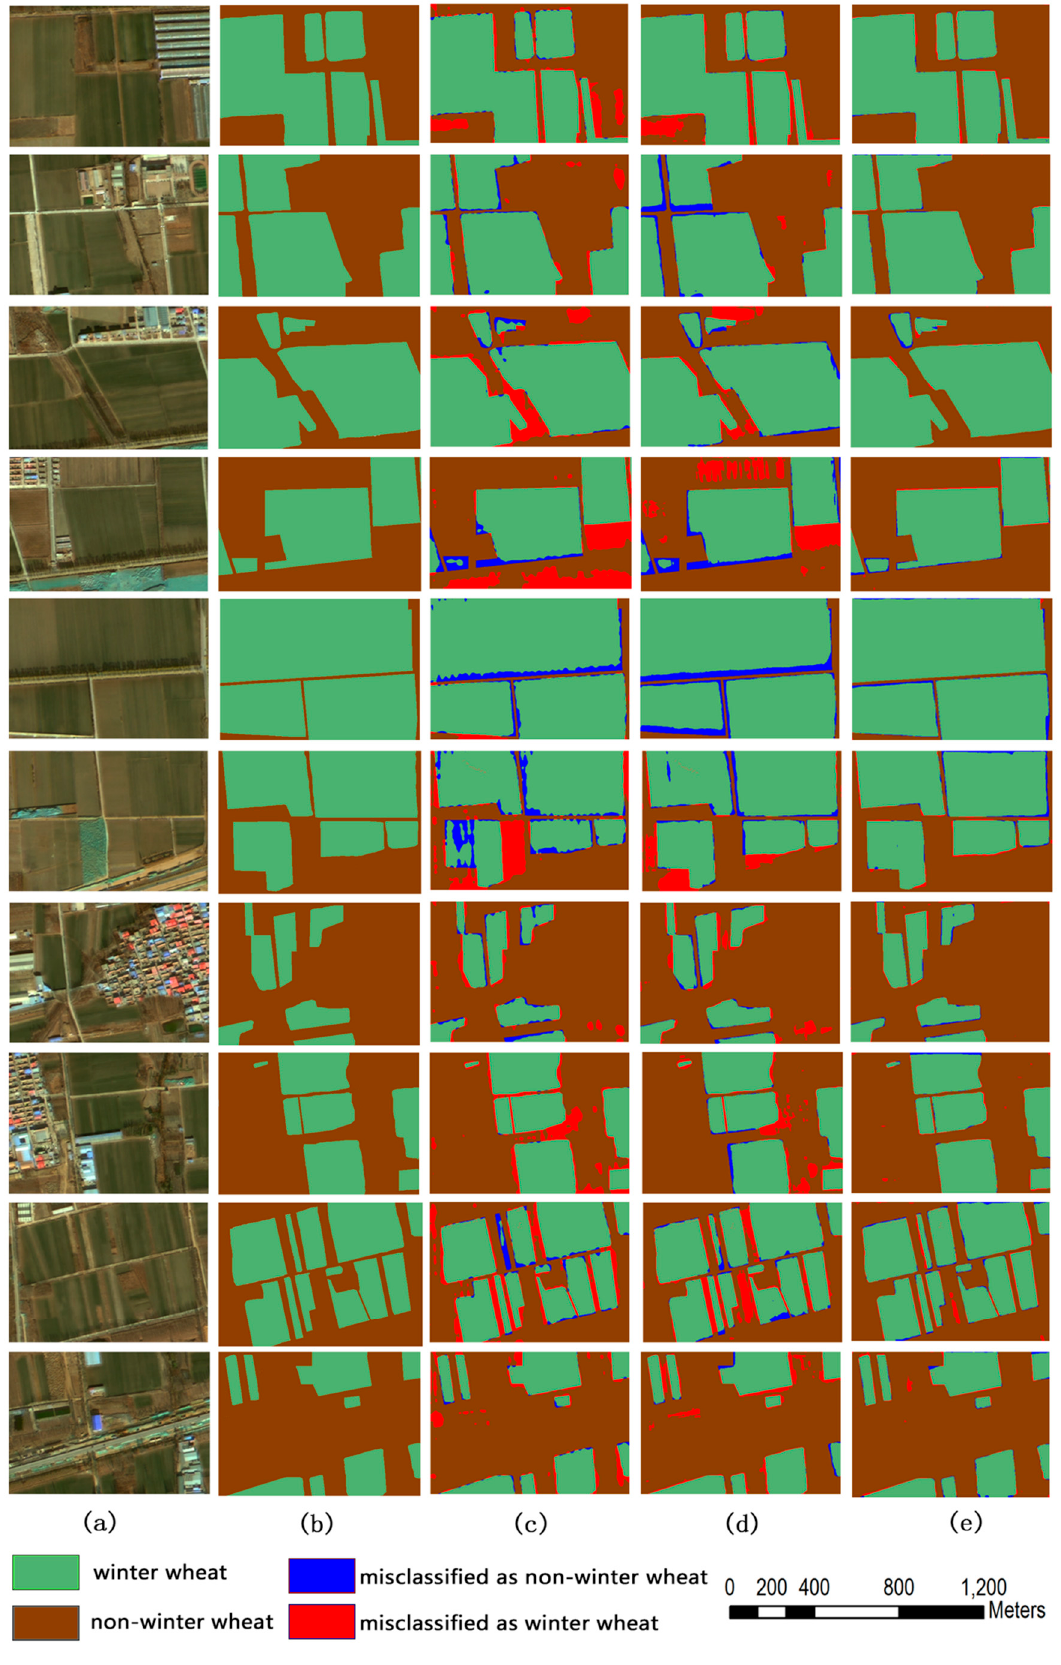
Figure 7. Comparison of segmentation results for Gaofen 2 imagery: ( a ) original images, ( b ) ground truth, ( c ) SegNet results, ( d ) RefineNet results, and ( e ) CEM results.